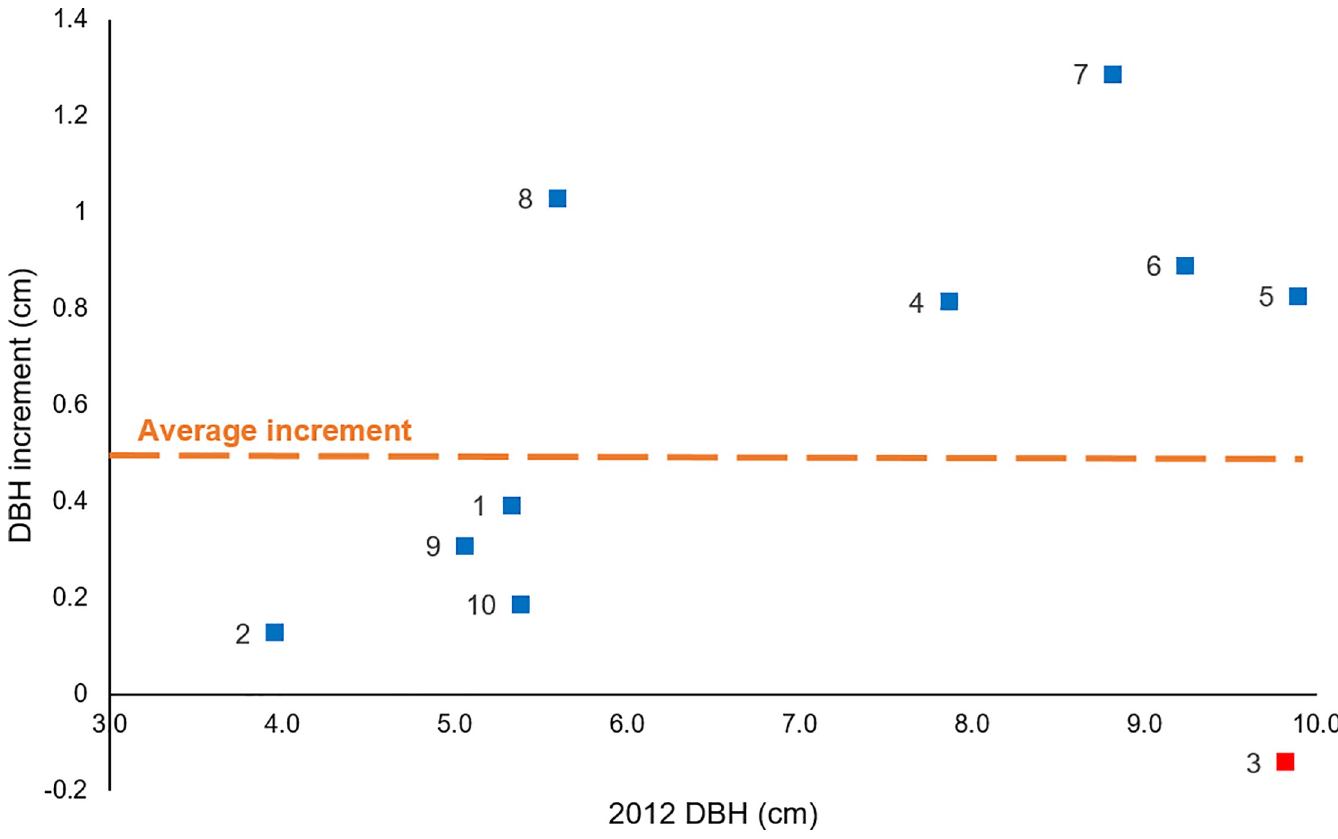
Fig 5. Diameter at breast height’s (DBH) increment (cm) per plot in the forest against 2012 DBH (cm). Blue squares represent the forest plots with positive DBH increment, red squares represent those with decreasing DBH. Orange dashed line is the average DBH increment among all forest plots, 0.5